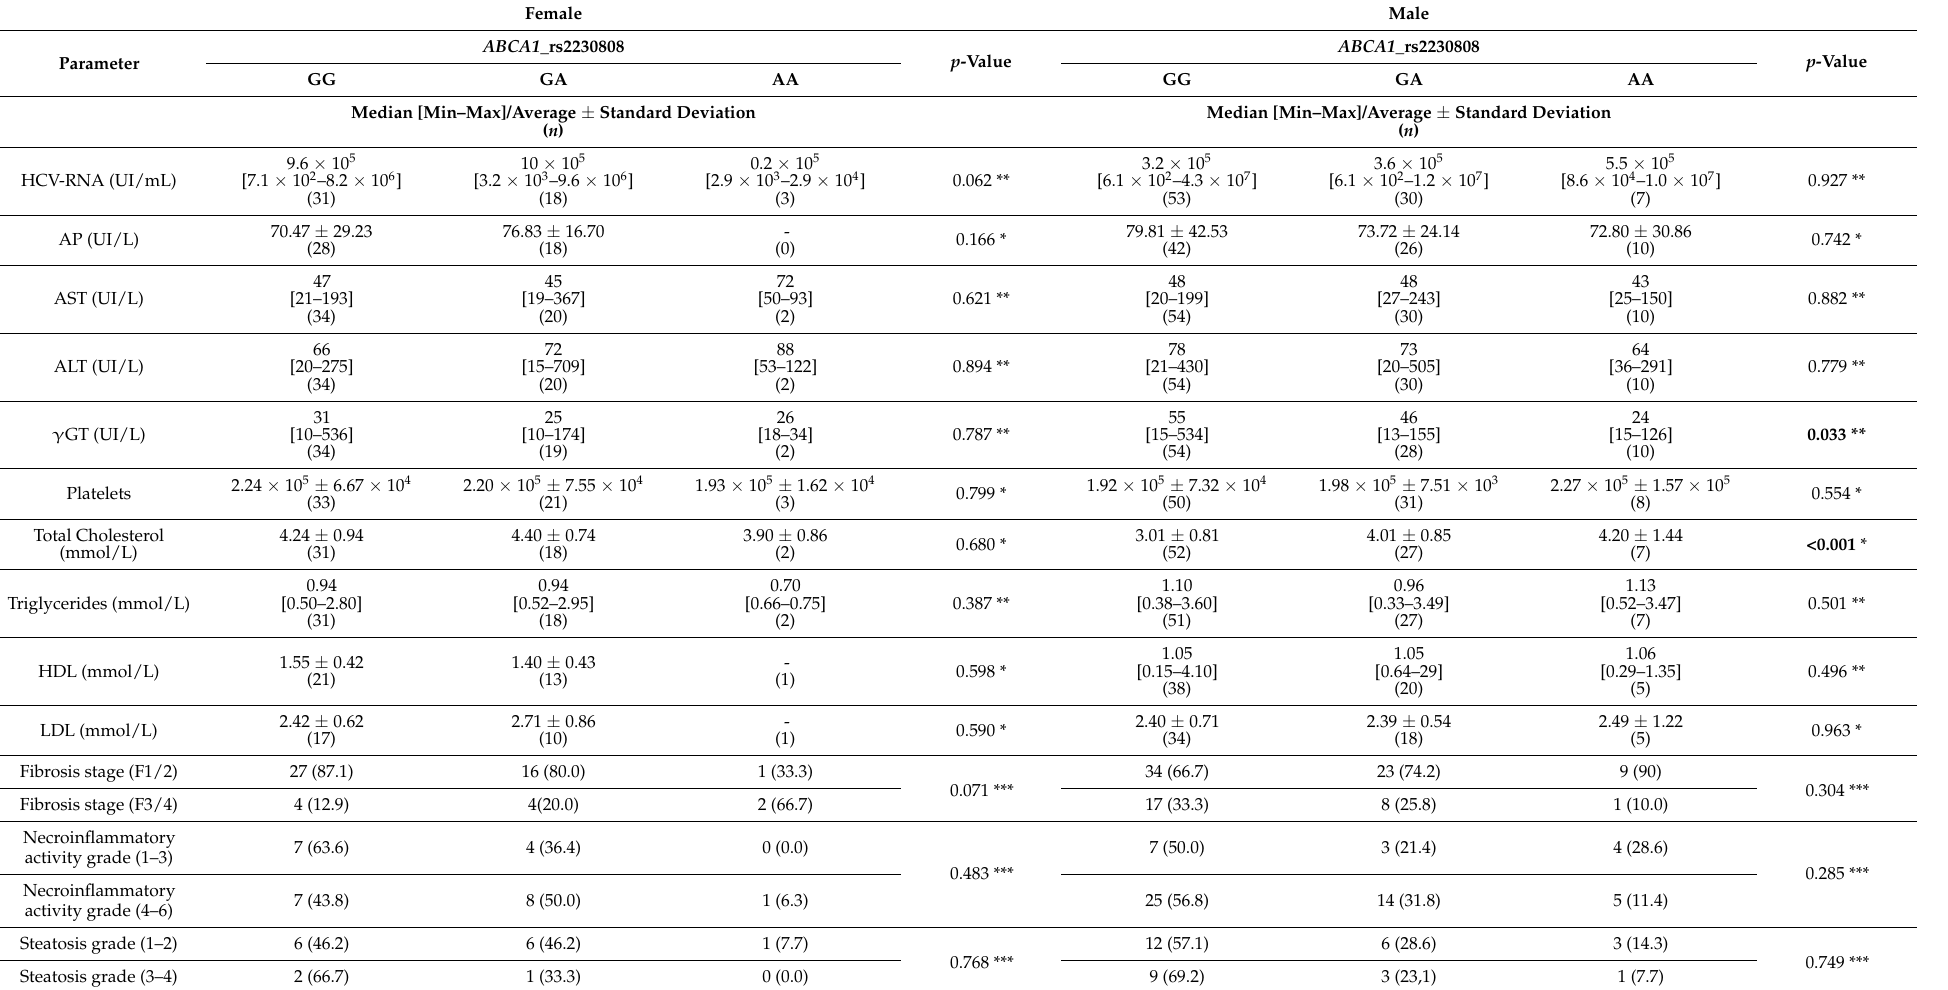
Table 2. Association of ABCA1 _rs2230808 with biochemical and histological